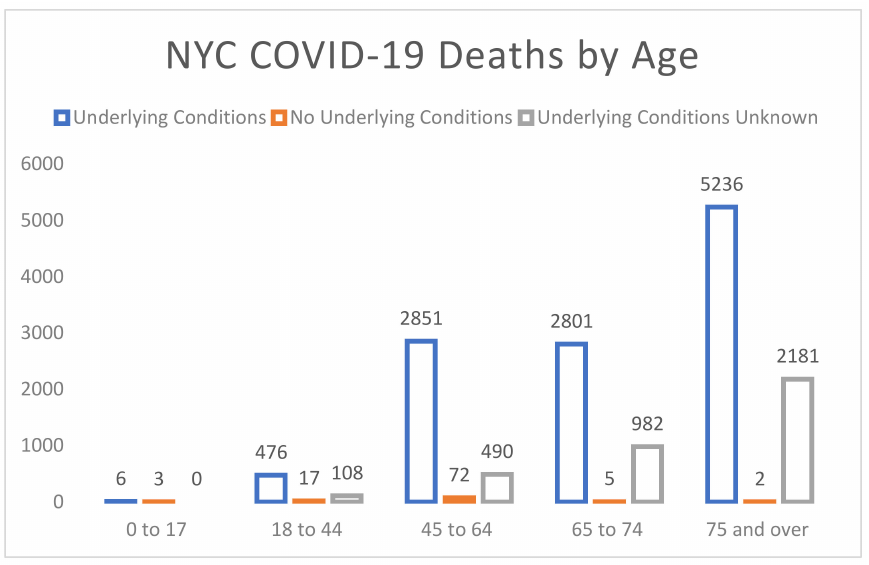
Figure 8. New York City COVID-19 deaths by age as of 12 May 2020. Note: Underlying conditions include diabetes, lung disease, cancer, immunodeficiency, heart disease, hypertension, asthma, kidney disease, GI/liver disease, and